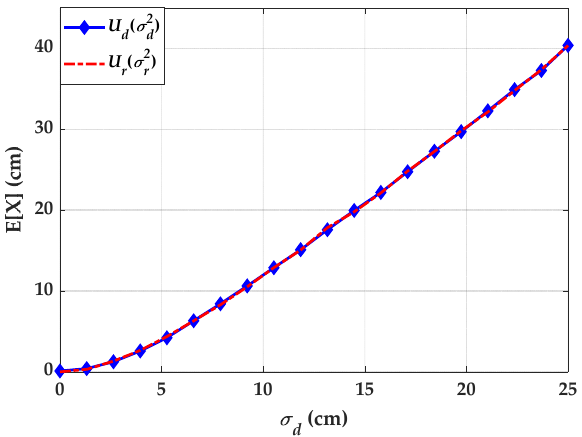
Figure 6. Study on Tx’s position uncertainty based on the direct and reverse processes. Simulating the uncertainty for the reverse process using the correction in (16) pro- vides the same values for the expectation as depicted in Figure 6 (curve labelled (cid:1847) (cid:3045) ).